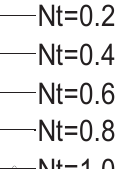
Table 2. Solutions of f (cid:48)(cid:48) ( 1,0 ) , θ ( 1,0 ) , and φ (cid:48) ( 1,0 ) for various values of f w at n = 1.0, Sc = 1.0, N = 1.0, γ = 2.01, ε = 0.45, κ = 0.5, and Nt = 1.0.